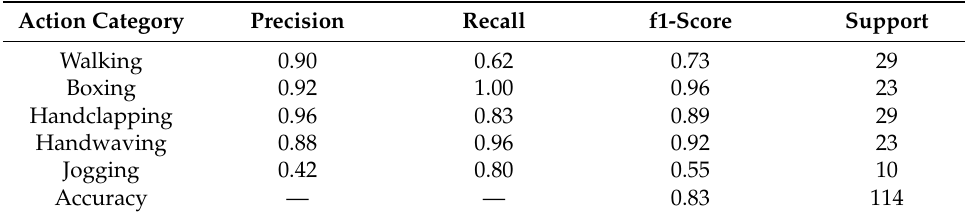
Table 2. Classification results for SC using KNN-DTW with KTH-5.